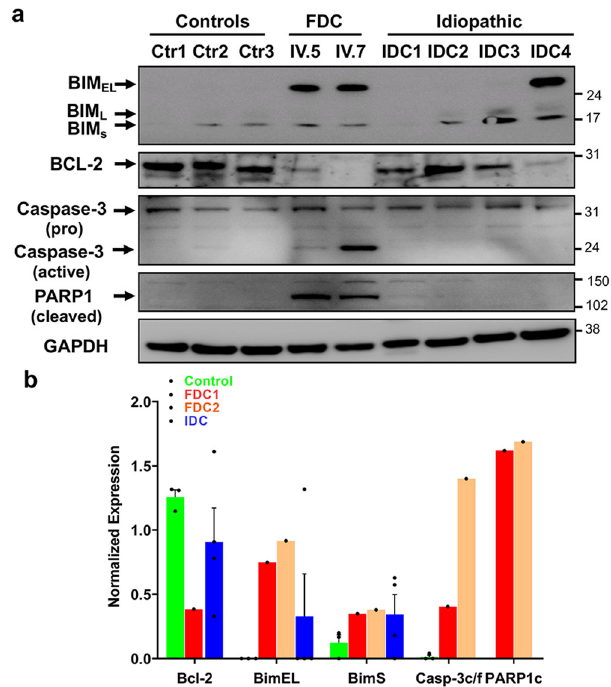
Fig. 3 Increased CHOP expression plays a role in the activation of apoptosis pathway in FDC hearts. a The expression of total protein levels of PARP-1 (cleaved), caspase-3 (pro and active), Bim, and BCL-2 were measured by western blot using heart tissue extracts from control hearts, familial hearts from the two patients with the FBXO32 mutation, and from IDC (idiopathic dilated hearts). Depending on the investigated protein, 25 – 40 μ g of whole protein extract was used to perform the western blot analysis. b Quantitative analysis of ( a ); results are normalized against GAPDH and expressed as average ± s.e.m. FDC familial